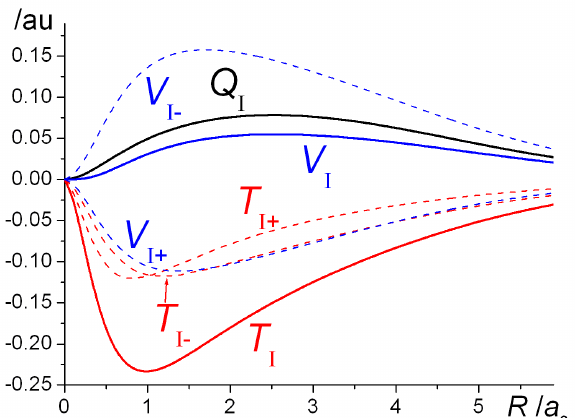
Figure 7. Interference terms for H 2 + with ζ optimized as functions of the internuclear distance R . Black line: charge transfer Q I into the bond. Red lines: Kinetic interference energies. Blue lines: Potential interferences energies. The contributions T I + and V I + from the density accumulation region defined by ρ I + (See Figure 5). Contributions T I − and V I − from the density depletion regions defined by ρ I − (See Figure 5). The individual contributions are shown by dashed lines, while the totals, shown by full lines, are the sums T I + + T I − and V I + + V I −